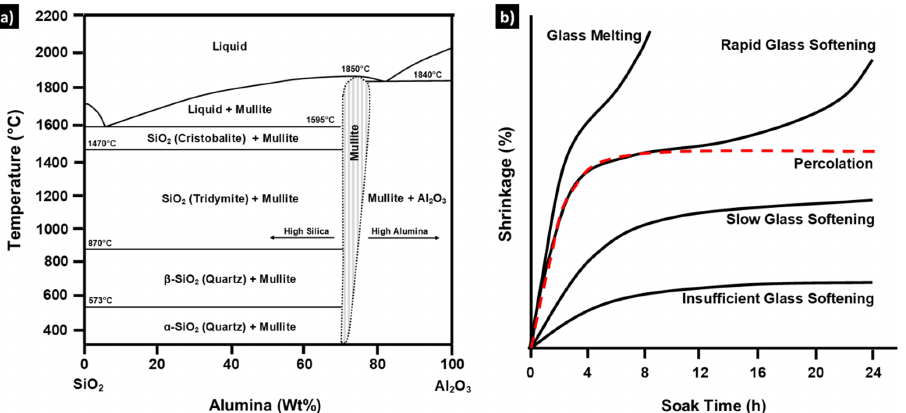
Figure 1. ( a ) Al 2 O 3 ‐ SiO 2 phase diagram, assuming congruently melting mullite (adapted from [10]) and ( b ) typical firing shrinkage curves for refractory products on sintering at high temperatures.